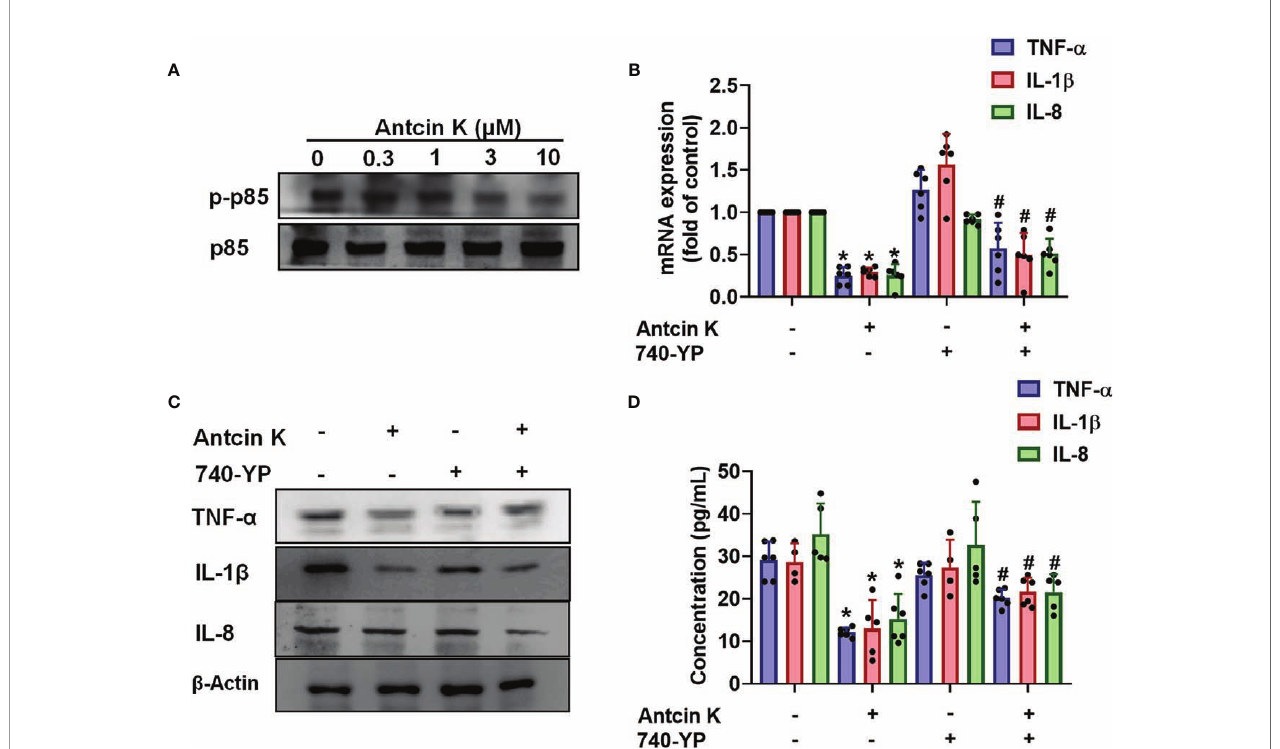
FIGURE 4 | The PI3K pathway is involved in Antcin K-induced inhibition of TNF- a , IL-1 b and IL-8 production in RASFs. (A) Cells were treated with Antcin K (0.3, 1, 3 or 10 m M) for 24 h and PI3K phosphorylation was examined by Western blot. (B – D) Cells were pretreated with PI3K activator 740-YP for 30 min, then treated with Antcin K (10 m M) for 24 h. TNF- a , IL-1 b and IL-8 mRNA expression and protein secretion were examined by qPCR, Western blot and ELISA. Results are expressed as the mean ± SD. * P < 0.05 compared with controls; # P < 0.05 compared with the Antcin K-treated